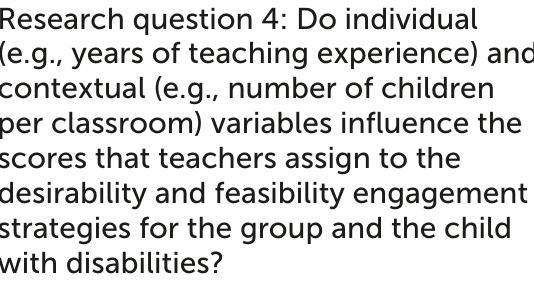
No. Knowledge items ( n , %)